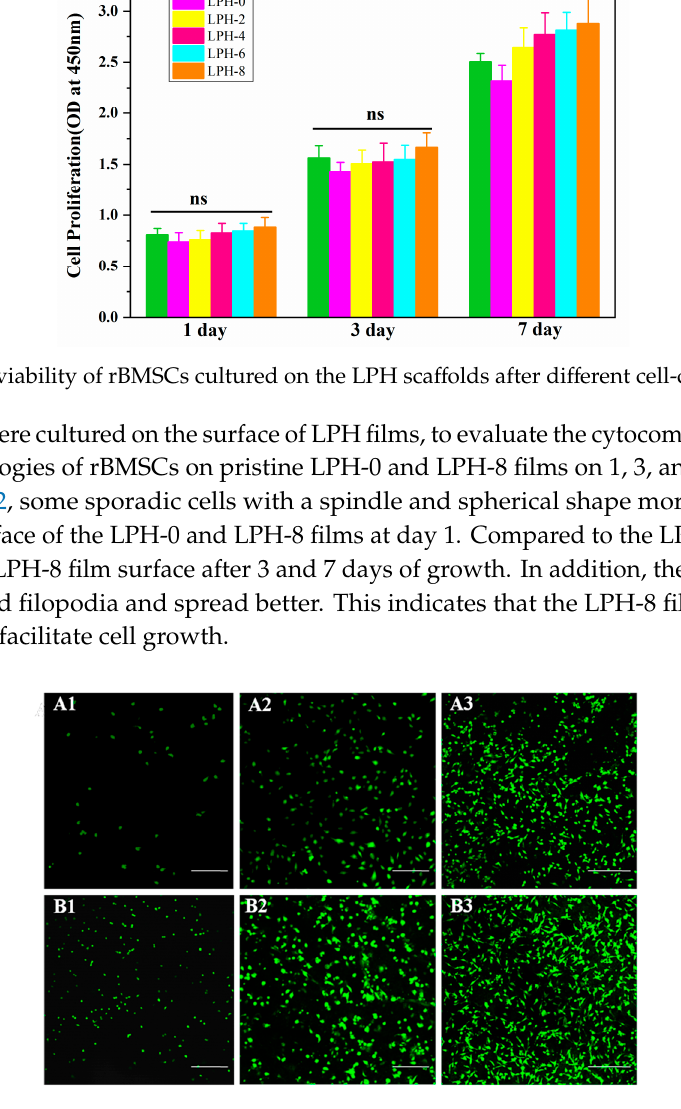
Figure 12. Cytocompatibility of rBMSCs on LPH ‐ 0 and LPH ‐ 8 samples for different days. The scale bars:300 μ m. ( A1 – A3 ) LPH ‐ 0 cultured at 1, 3, and 7 days; ( B1 – B3 ) LPH ‐ 8 cultured at 1, 3, and 7 days.